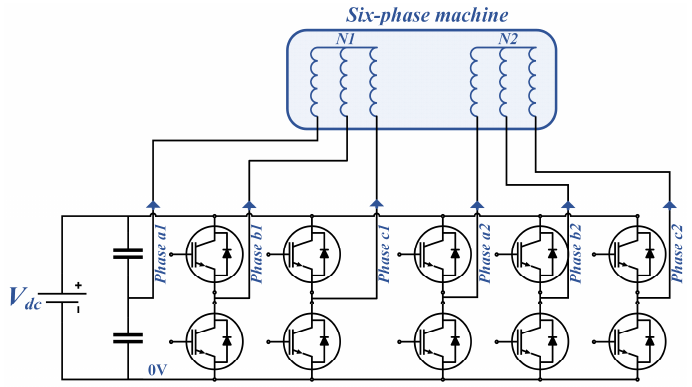
Figure 21. Topology 2: structure of a five-leg inverter for a six-phase machine.